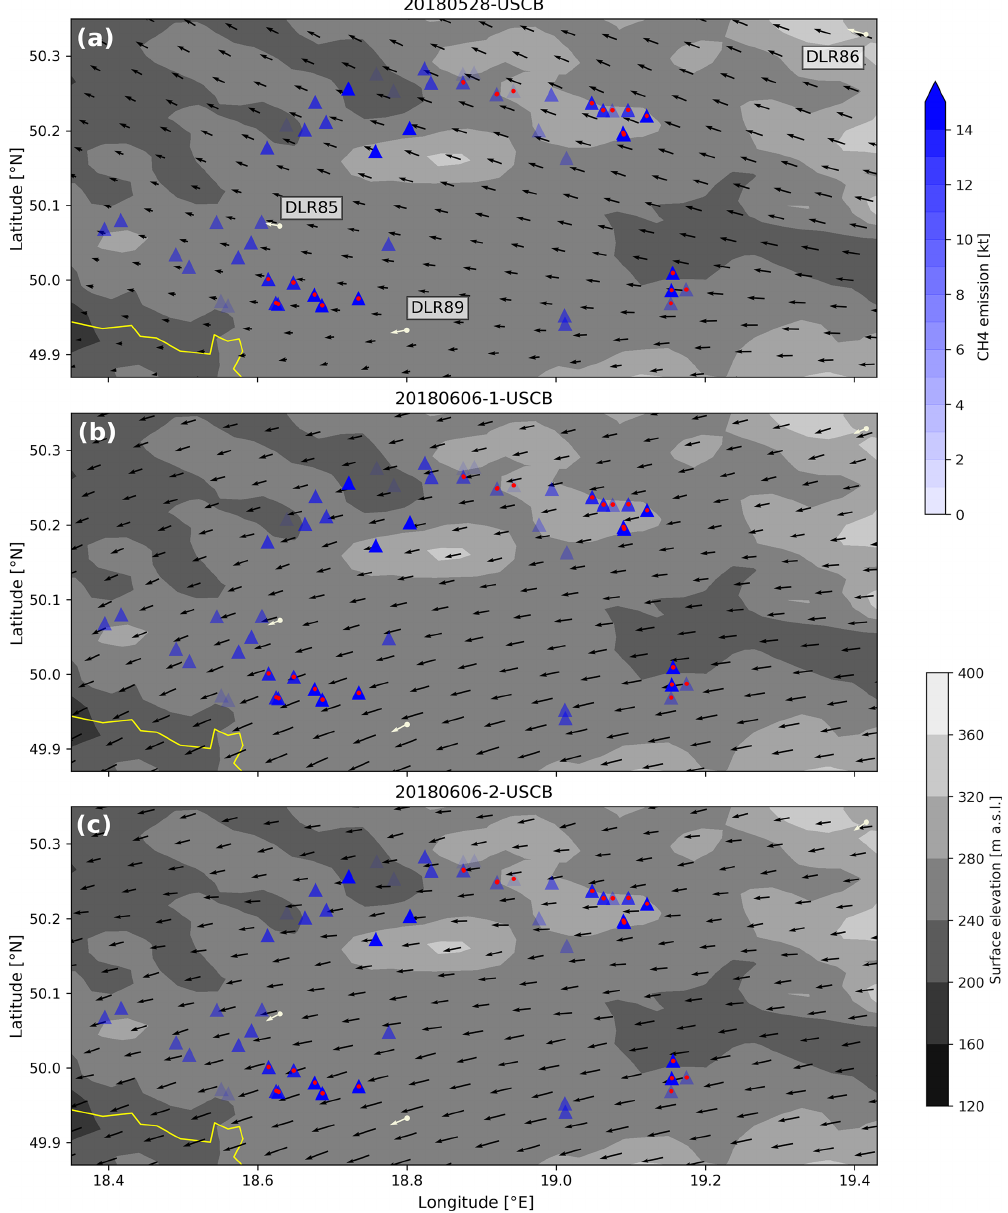
Figure B1. Similar to Fig. 4 but for the remaining three flights on 28 May (a) , 6 June in the morning (b) , and in the afternoon (c)